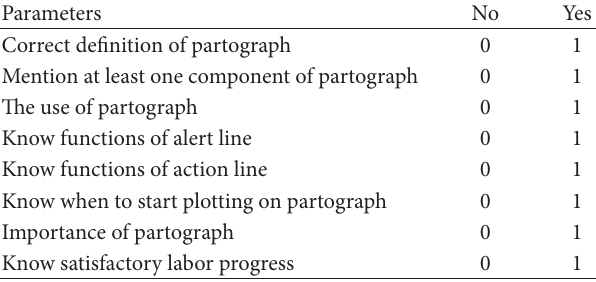
Table 1: Criteria for the partograph knowledge score.